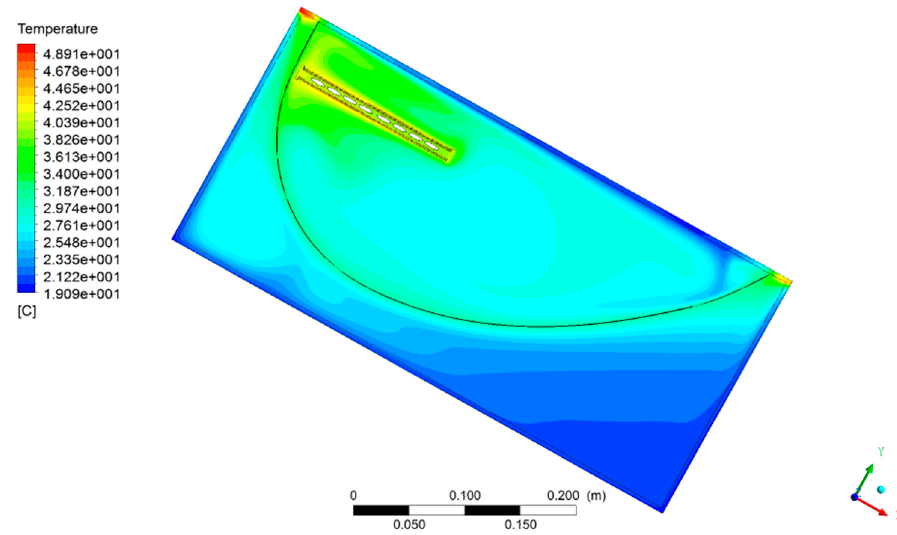
Figure 18. Temperature contours inside the collector.